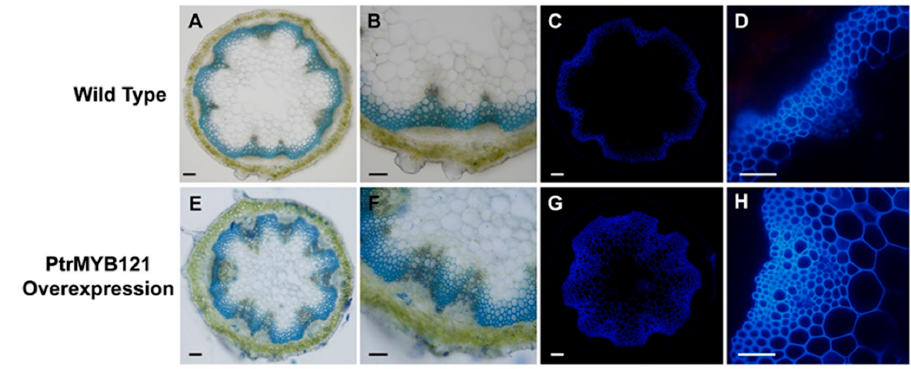
Figure 4. Tissue sections of inflorescence stems of PtrMYB121 -overexpressing transgenic Arabidopsis. The toluidine blue O (TBO) staining and lignin autofluorescence in the inflorescence stems of 40-day-old WT (WT-1) and PtrMYB121 -overexpressing Arabidopsis (L1). Histochemical staining of the cross- sections of inflorescence stem of 40-day-old WT ( A and B ) and PtrMYB121 -overexpressing ( E and F ) Arabidopsis. Lignin autofluorescence of the inflorescence stem of 40-day-old WT ( C and D ) and PtrMYB121 -overexpressing ( G and H ) Arabidopsis. Bars: A,C,E,G = 500 µm and B,D,F,H = 100 µm.